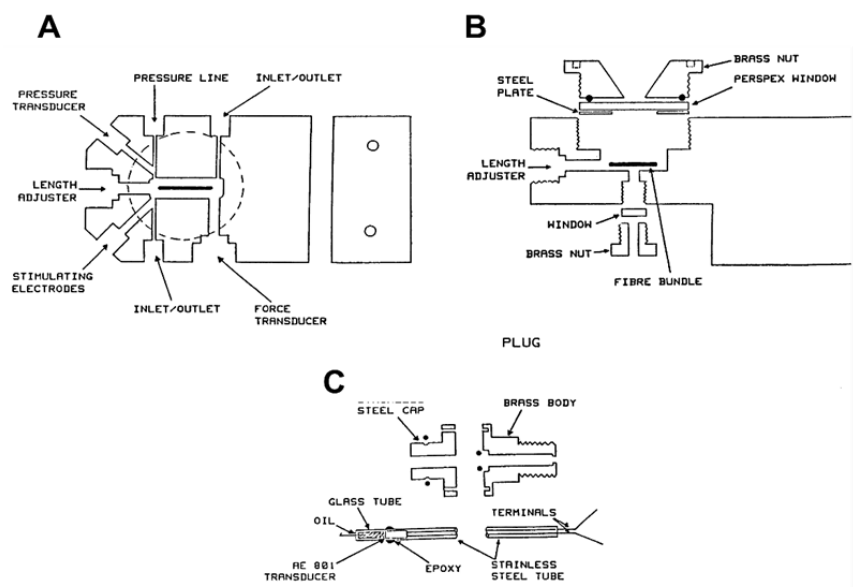
Figure 1. Schematic diagrams of the pressure chamber. ( A ) Top view of a cross-section showing ports. ( B ) A vertical cross-section showing the two Perspex windows. Muscle fibre bundle is shown by a dark line. ( C ) The force transducer plug: an AE 801 transducer element was glued to a stainless steel tube that could be pressure-sealed; the beam of the AE 801 element was enclosed in a glass tube and filled with paraffin for electrical insulation, when transducer was within chamber. (Filled circles show positions of some of the rubber O-rings for pressure sealing, adapted from Ranatunga et al., [8]).